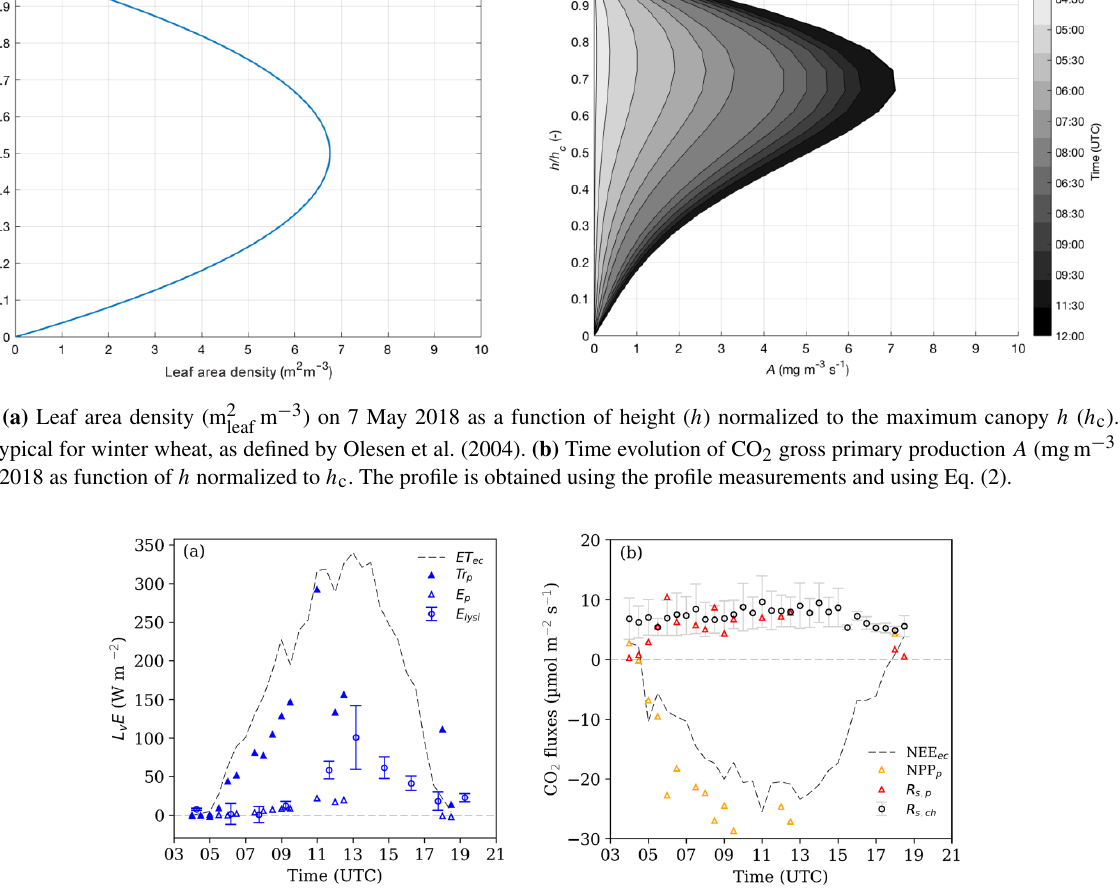
Figure 9. Source partitioning results for (a) H 2 O and (b) CO 2 fluxes for IOP 1. Dashed grey lines show the measured latent heat flux (ET ec ) and net ecosystem exchange (NEE ec ) in half-hourly time steps. Values with subscript index p indicate estimates based on inversed profile concentration measurements (Sect. 3.4). Error bars for evaporation calculated from microlysimeters ( E lysi ) and soil respiration measurements ( R s , ch ) indicated to 1SD. (ET ec : evapotranspiration measured as latent heat flux L v E by the eddy covariance system; E : evaporation; T r p : transpiration; NPP: above-ground net primary production; R s : soil